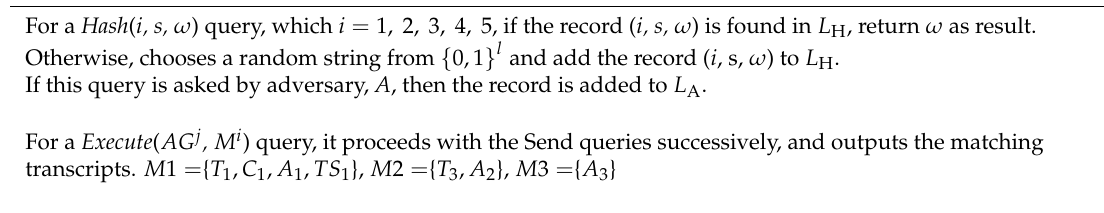
Table 13. Simulation of other queries. Simulation of Other